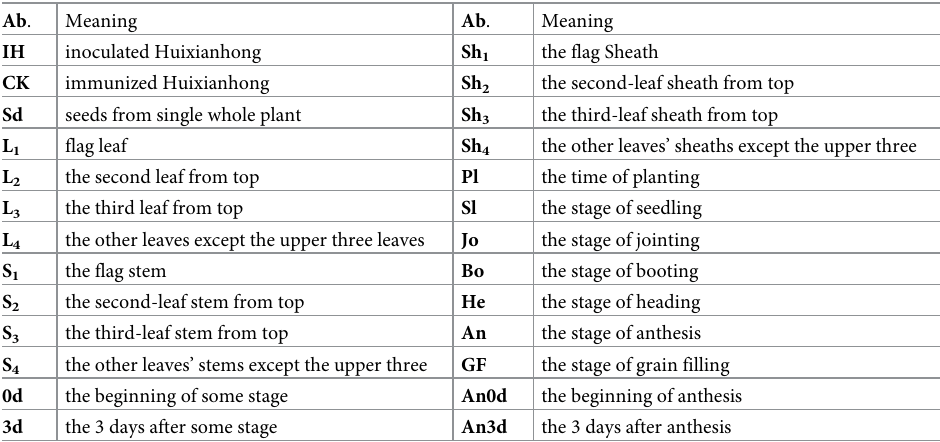
Table 1. The abbreviation of growth stage and organs. Ab . Meaning Ab . Meaning IH inoculated Huixianhong Sh 1 the flag Sheath CK immunized Huixianhong Sh 2 the second-leaf sheath from top Sd seeds from single whole plant Sh 3 the third-leaf sheath from top L 1 flag leaf Sh 4 the other leaves’ sheaths except the upper three L 2 the second leaf from top Pl the time of planting L 3 the third leaf from top Sl the stage of seedling L 4 the other leaves except the upper three leaves Jo the stage of jointing S 1 the flag stem Bo the stage of booting S 2 the second-leaf stem from top He the stage of heading S 3 the third-leaf stem from top An the stage of anthesis S 4 the other leaves’ stems except the upper three GF the stage of grain filling 0d the beginning of some stage An0d the beginning of anthesis 3d the 3 days after some stage An3d the 3 days after anthesis Note: The table detailed and introduced the abbreviation of different growth stages and different